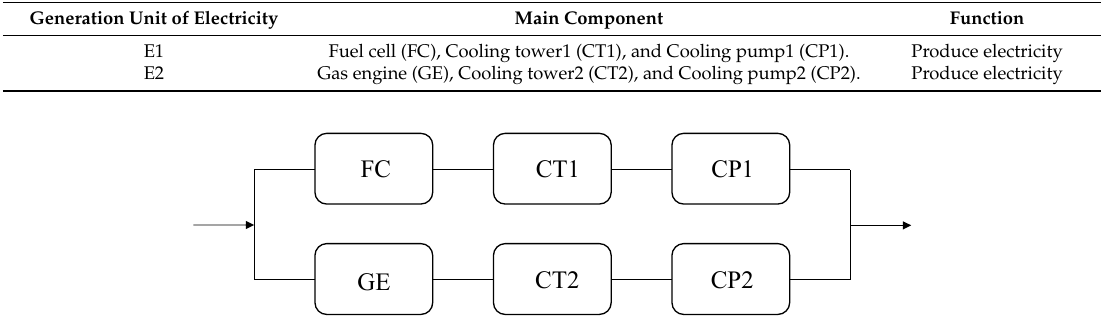
Figure 5. The reliability block diagram of an electricity subsystem of the CCHP system.